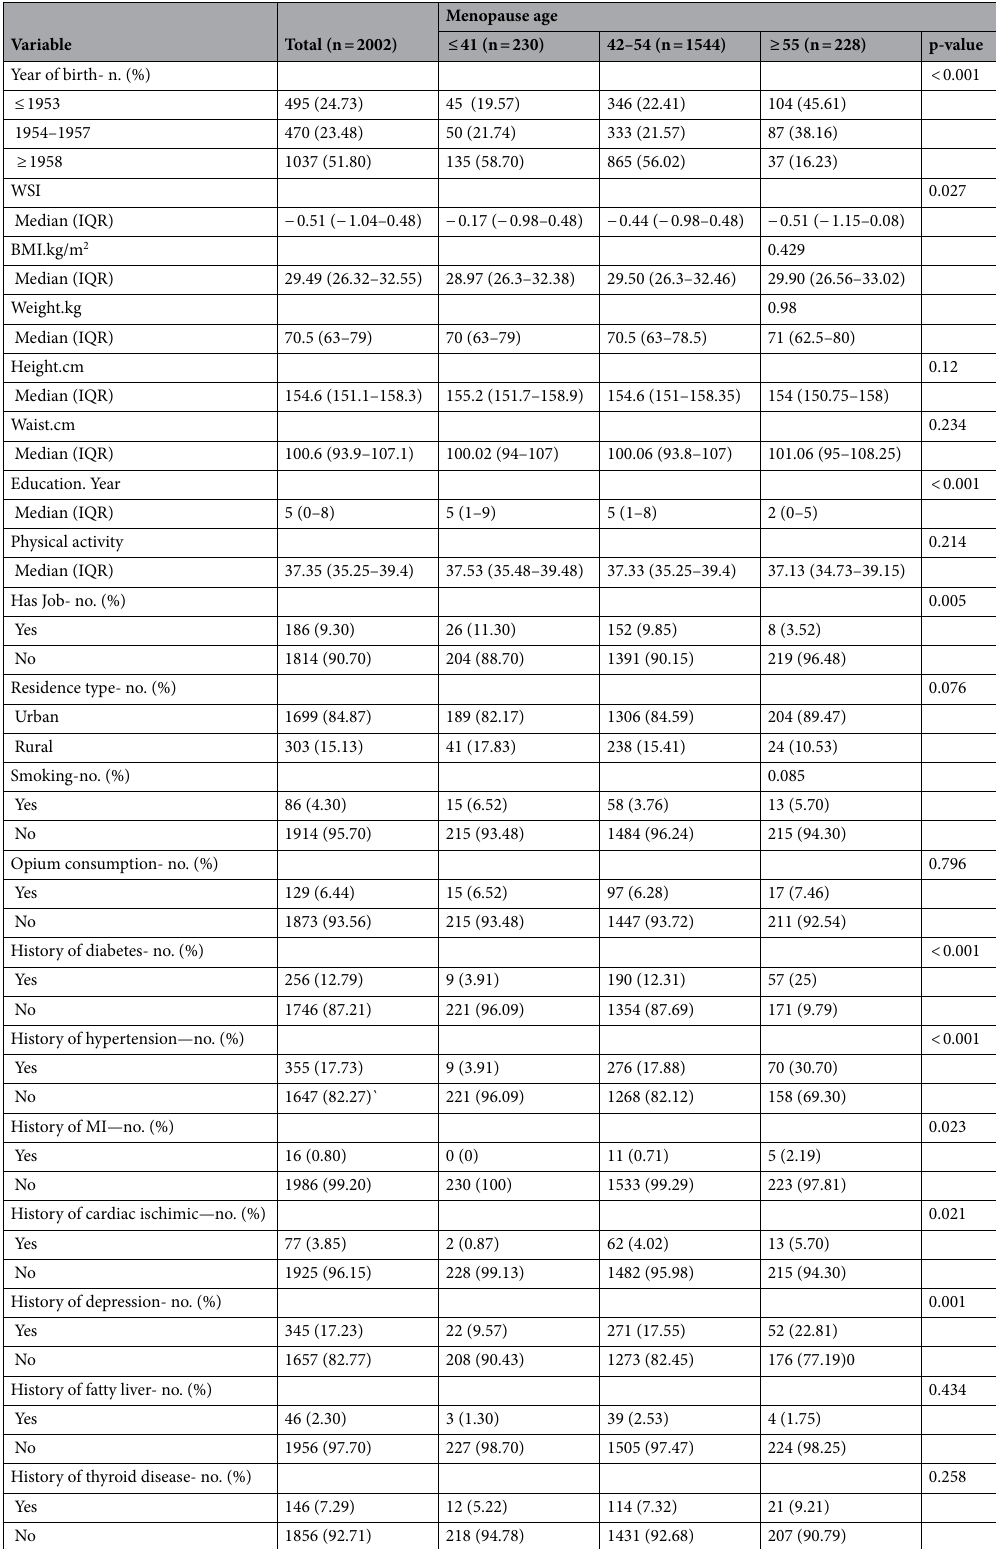
Table 1. Demographic characteristics of women according to age at menopause in Rafsanjan Cohort Study (RCS). WSI Wealth score index, BMI body mass index, MI myocardial